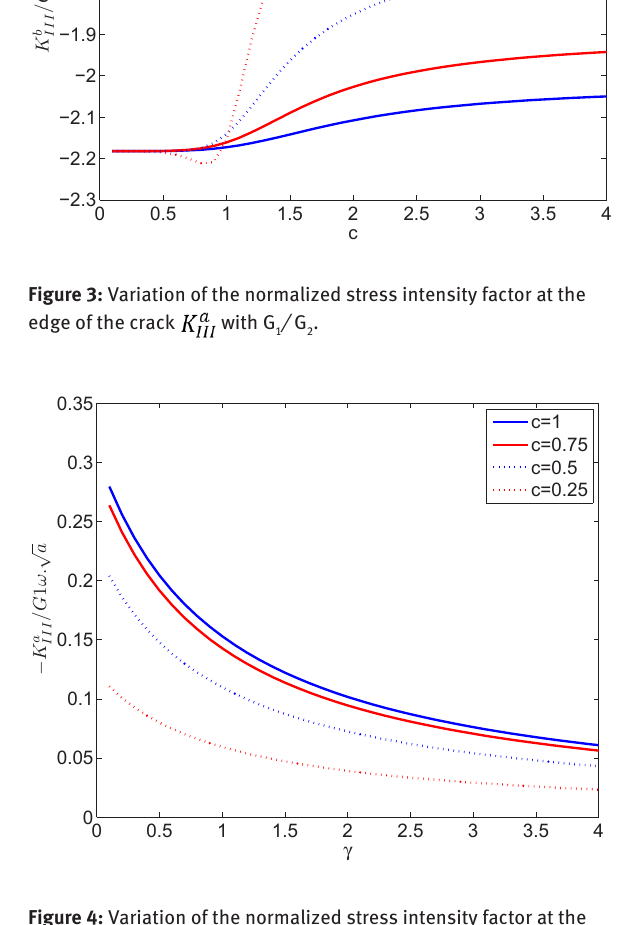
Figure 4: Variation of the normalized stress intensity factor at the edge of the rigid disc with